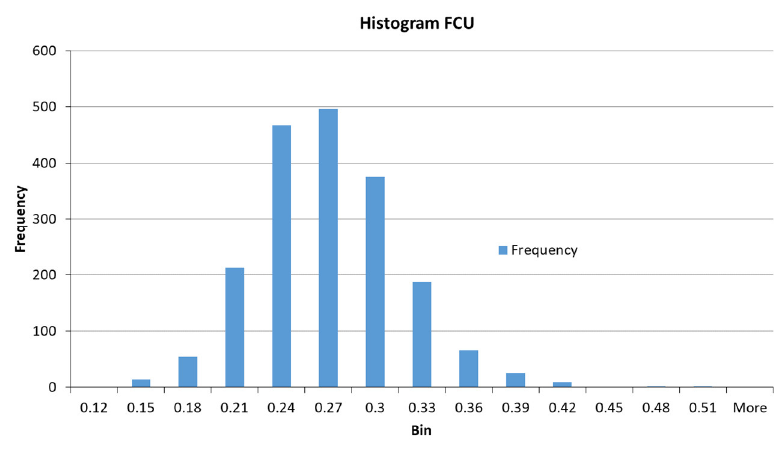
Figure A2. Copper content in feed (FCU)—dataset distribution.